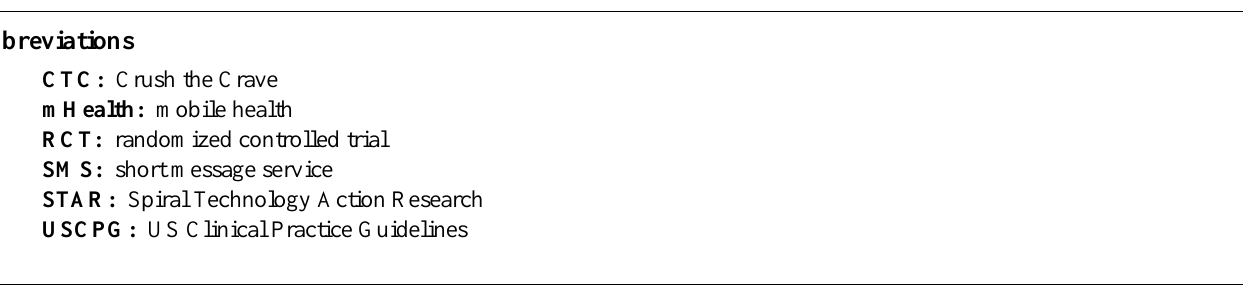
STAR: Spiral Technology Action Research USCPG: US Clinical Practice